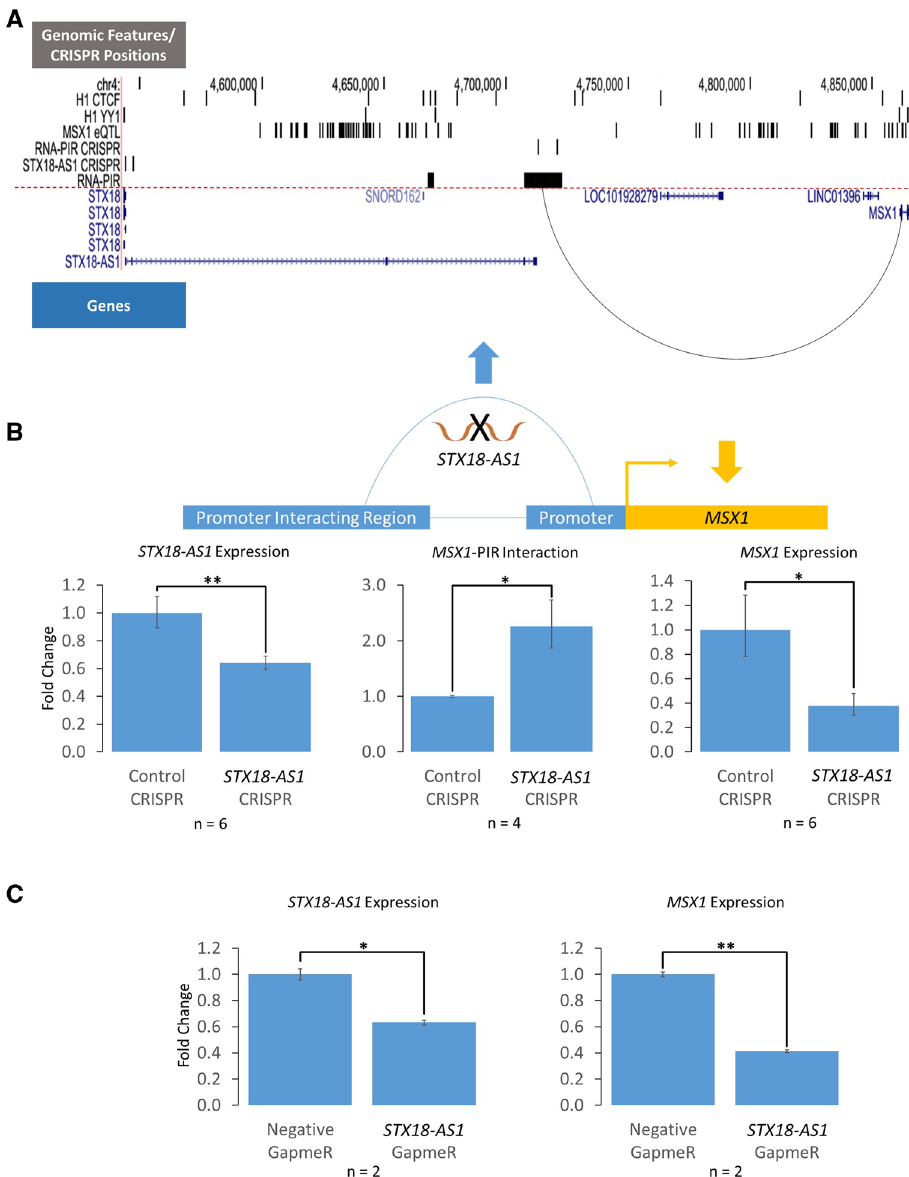
Figure 4. Chromosomal interaction between MSX1 promoter and its promoter interacting region (PIR) mediated by a noncoding RNA, STX18-AS1 . (A) Genomic locations of MSX1 and STX18-AS1 genes, CTCF and YY1 binding sites in H1 human embryonic stem cells (hESCs), GTEx expression quantitative trait loci (eQTLs) targeting MSX1 gene, guide RNA (gRNA) sequences for deleting the first two exons of STX18-AS1 gene and part of MSX1 PIR using CRISPR-Cas9, and PIRs associated with RNAs (the MSX1 promoter-PIR interaction was represented by an arc line). (B) Effects of STX18-AS1 down-regulation by deleting part of STX18-AS1 gene using CRISPR-Cas9 on MSX1 expression and MSX1 promoter-PIR interaction. (C) Effects of STX18-AS1 down- regulation by a specific GapmeR on STX18-AS1 and MSX1 expression levels. (D) Effects of downregulated MSX1 promoter-PIR interaction by deleting part of MSX1 RNA-PIR using CRISPR-Cas9 on expression levels of STX18-AS1 and MSX1 . E) Effects of STX18-AS1 and MSX1 RNA-PIR CRISPR-Cas9 deletions, and STX18-AS1 GapmeR on expression levels of STX18 , SOX2 and OCT4 .*P < 0.05; **P < 0.01. All p-values were obtained from T tests with Bonferroni correction if multiple comparisons